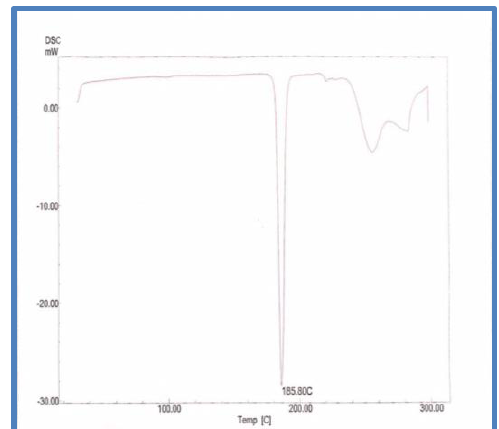
Figure 2. Differential scanning calorimetry thermogram of